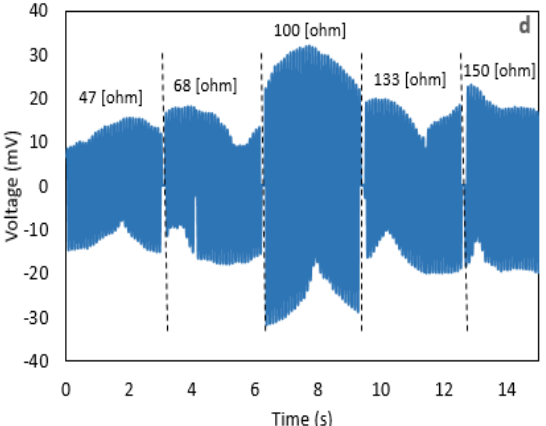
Figure 3. Time history for voltage as the load resistance is swept from 40-150 Ω at frequencies a. 4 Hz, b. 6 Hz, c. 8 Hz, d. 10 Hz